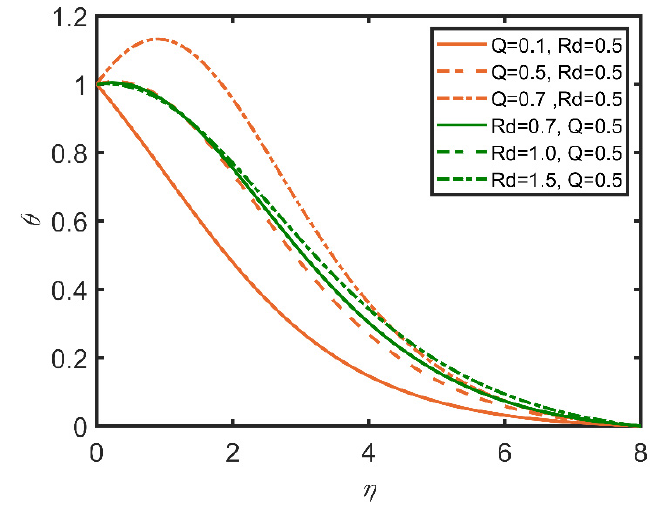
Figure 20. Comparison for temperature profile against 𝜂 .